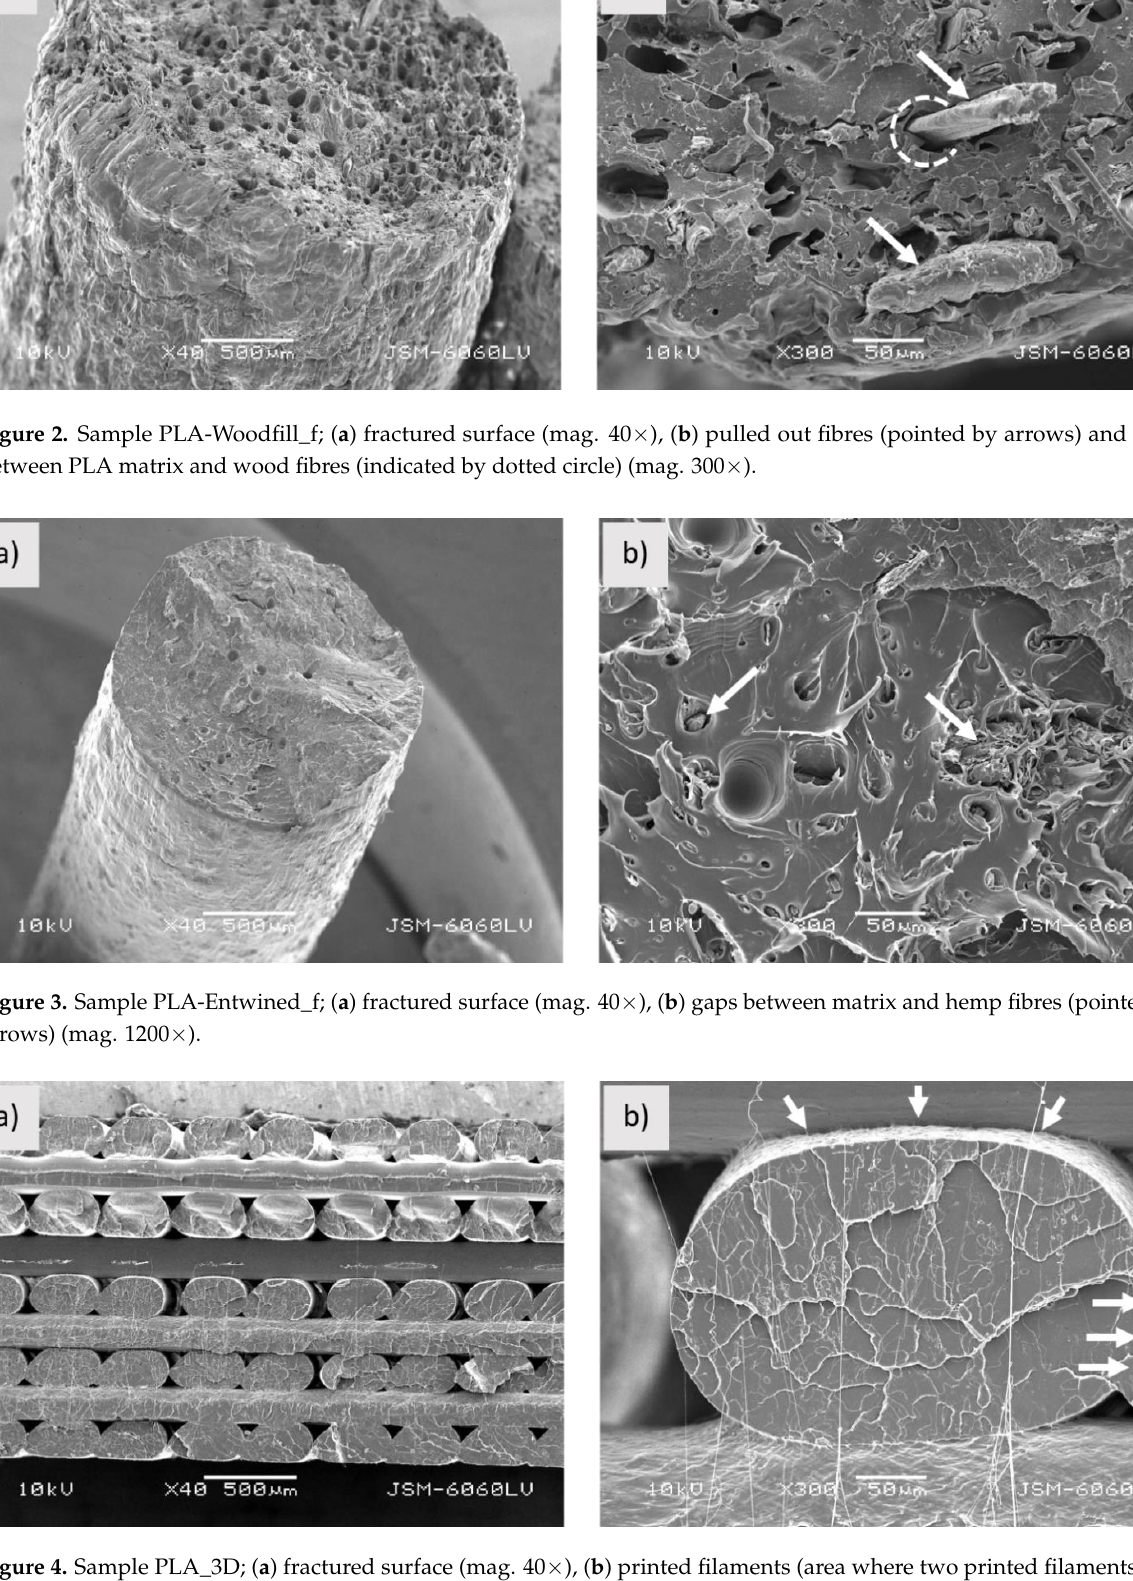
Figure 4. Sample PLA_3D; ( a ) fractured surface (mag. 40×), ( b ) printed filaments (area where two printed filaments and layers are firmly connected are pointed by arrows) (mag. 300×).